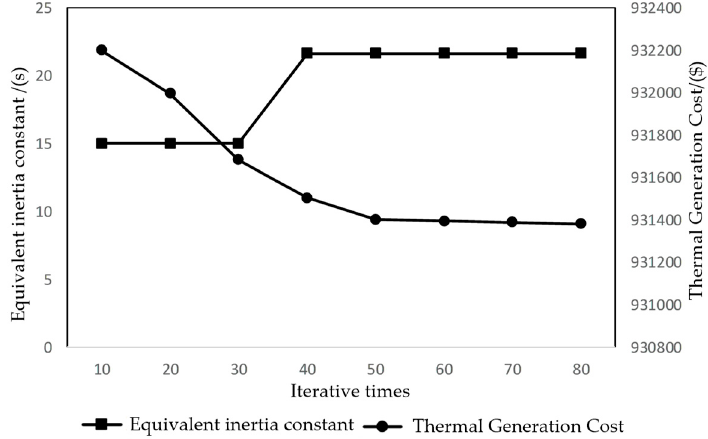
Figure 11. Convergence situation of the objectives as the number of iterations increases.